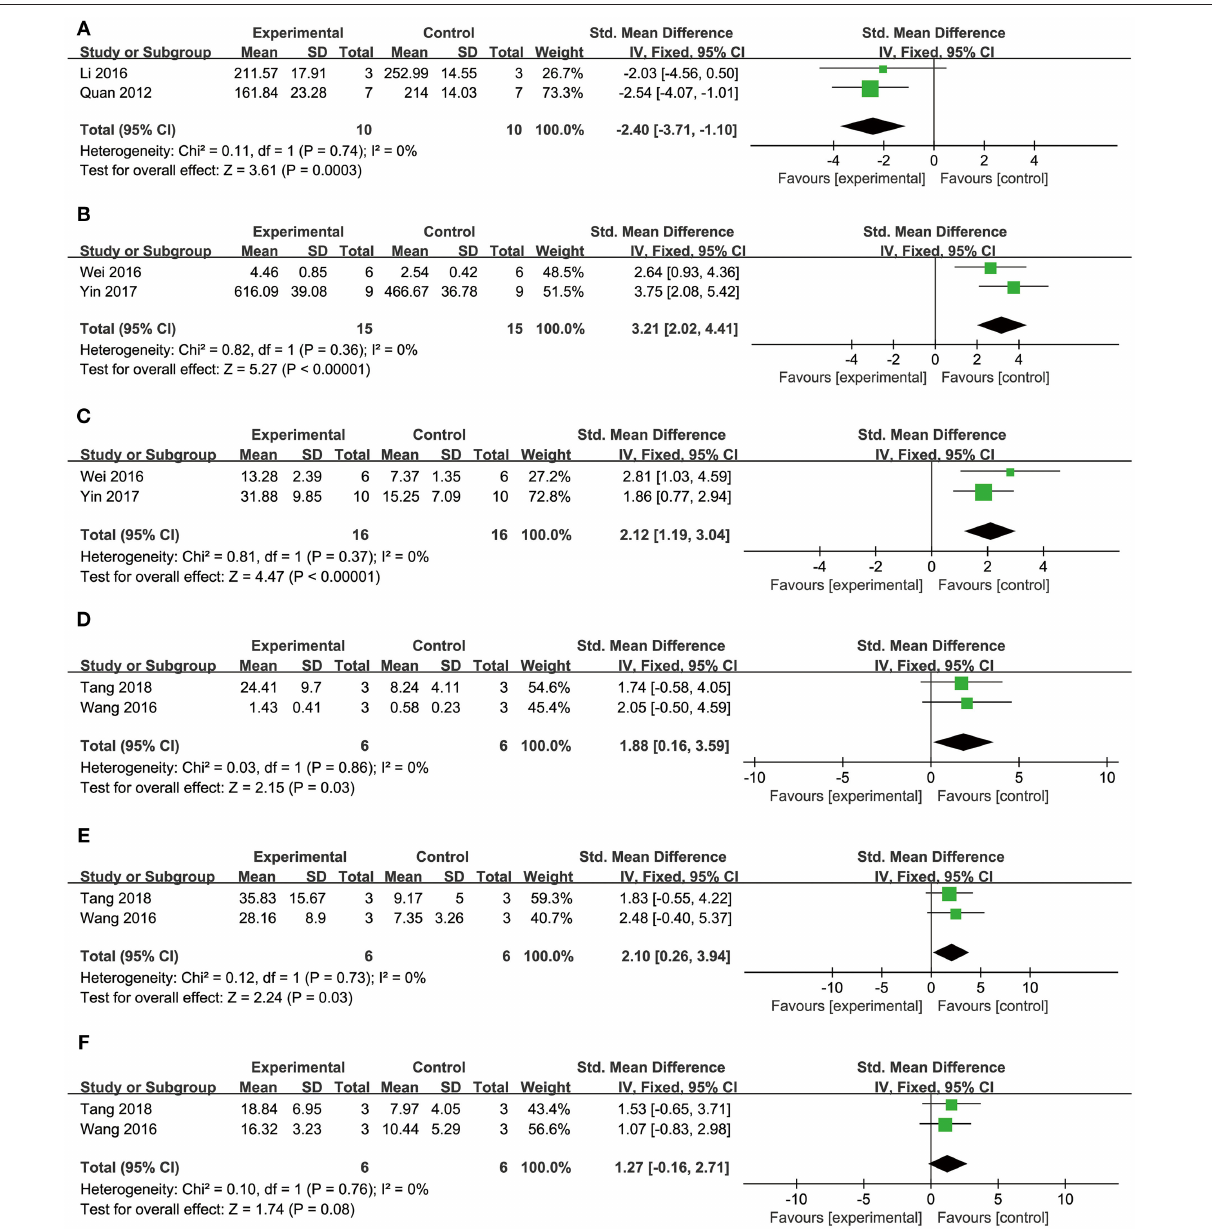
increasing stromal cell-derived factor-1 α (SDF-1) ( n = 30, SMD: 3.21, 95% CI: 2.02–4.41, P < 0.00001; heterogeneity χ 2 = 0.82, P = 0.36, I 2 = 0%; Figure 5B ), micro vessel density (MVD) ( n = 32, SMD: 2.12, 95% CI: 1.19–3.04, P < 0.00001; heterogeneity χ 2 = 0.81, P = 0.37, I 2 = 0%; Figure 5C ), C-X-C chemokine receptor type 4 (CXCR-4) ( P < 0.01) and vascular